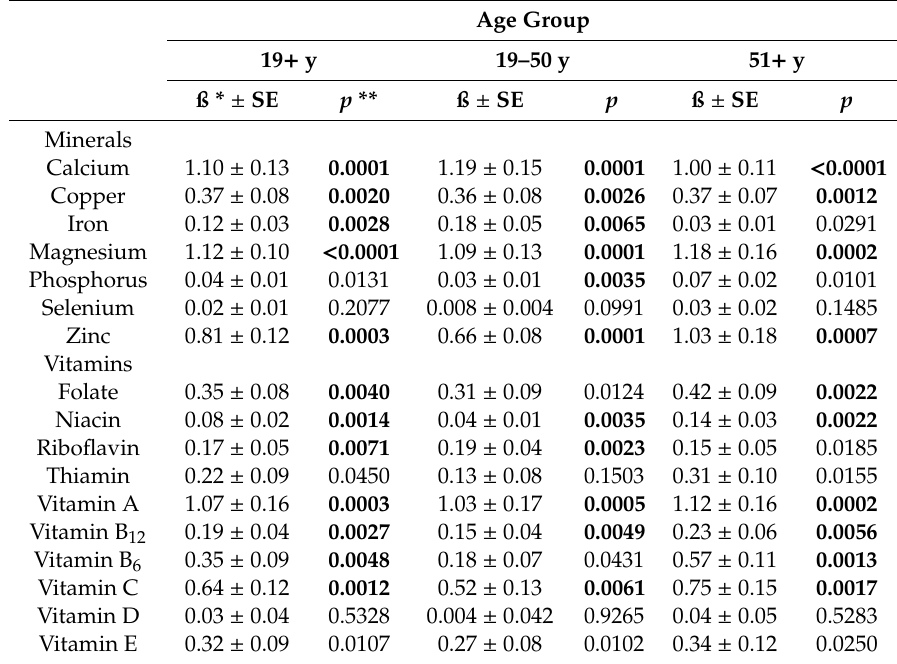
Table 5. Curvilinear association between added sugars intake (% of calories) and percentage of adults 19 + y (NHANES 2009–2014) with micronutrient intakes below the EAR 1 across sugar intake deciles.